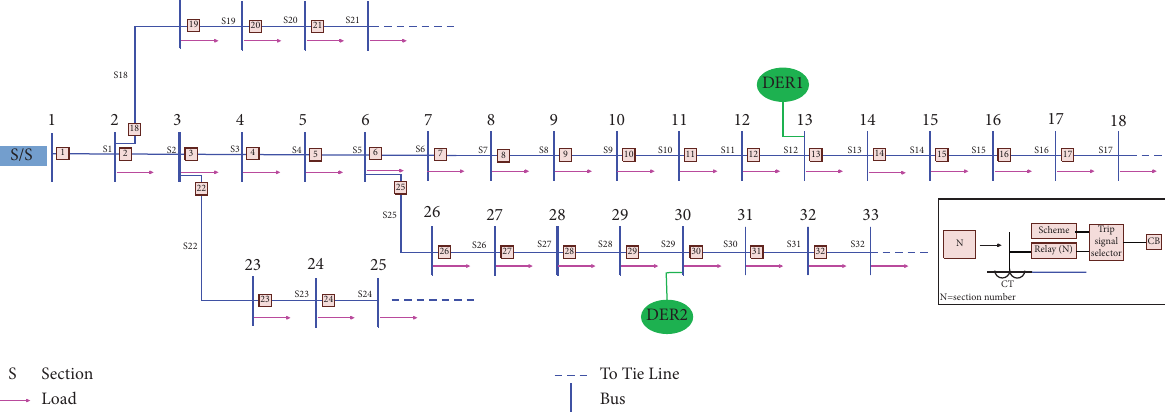
Figure 5: IEEE 33 bus distribution network with DER.